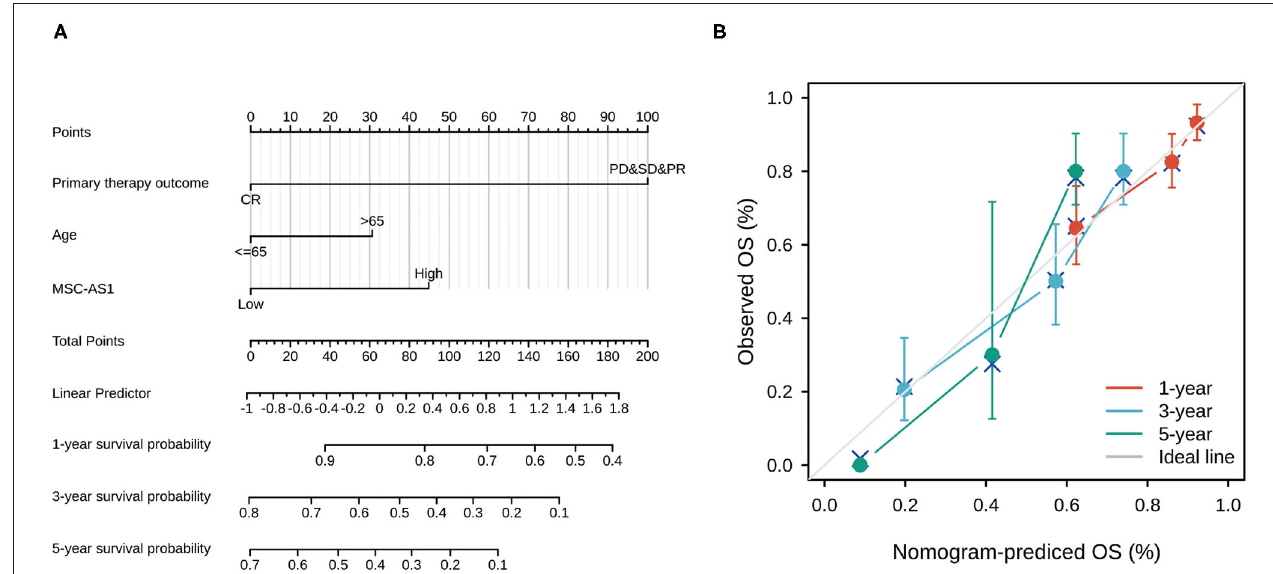
FIGURE 6 | (A) Nomogram for predicting the probability of 1-, 3-, and 5-year overall survival (OS) for patients with gastric cancer. (B) Calibration plot of nomogram for predicting the probability of OS at 1, 3, and 5 years. The abscissa was the probability of the prognosis predicted by the model (0-1: the probability of the event occurring is 0–100%), and the ordinate was the actual observed prognosis. The colored line was the fit line and represented the predicted value (the horizontal axis) corresponding to the actual value (the vertical axis). The gray diagonal was the ideal case.